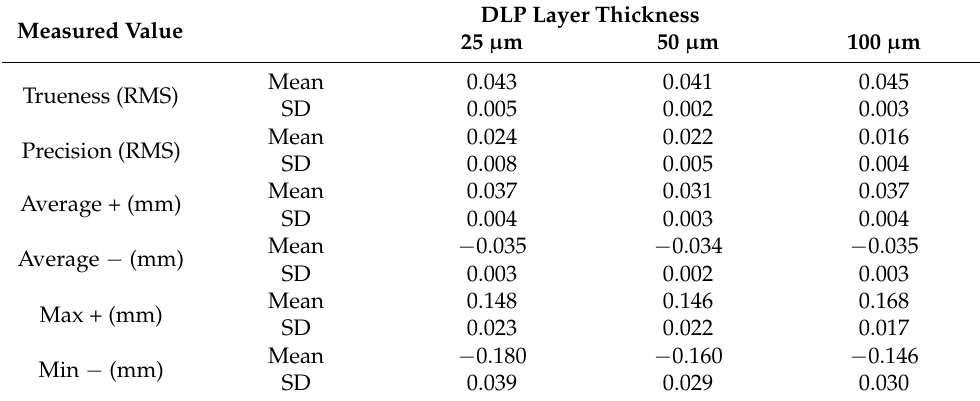
Figure 10. Mean trueness and precision root mean square (RMS) values ( n = 12) comparison depending on layer thickness. All data is normally distributed. Groups compared by all pairs Tukey–Kramer HSD analysis ( p < 0.05) and statistically comparable groups were denoted by letters. All groups from precision were statistically different ( p < 0.05). Lower RMS values correspond to higher trueness and precision. Table 2. Values from the superimposition process for the different layer thicknesses. Means and standard deviations are given for the following parameters: root mean square (RMS) of trueness, RMS of precision, positive and negative average deviation, as well as maximum and minimum